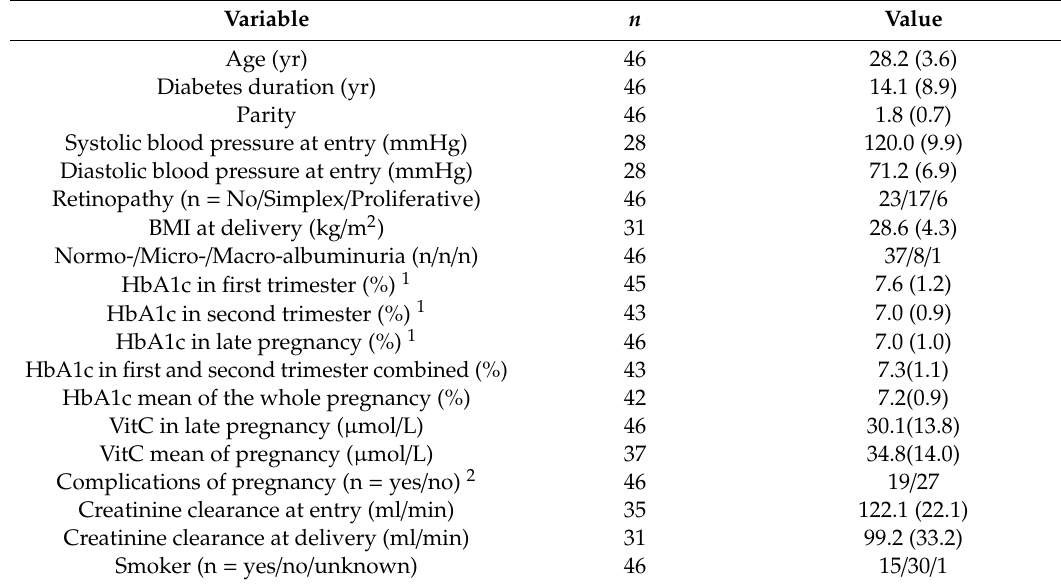
Table 1. Clinical data and characteristics of the study population. Values are reported as mean (SD) for normally distributed quantitative data or as frequencies for qualitative